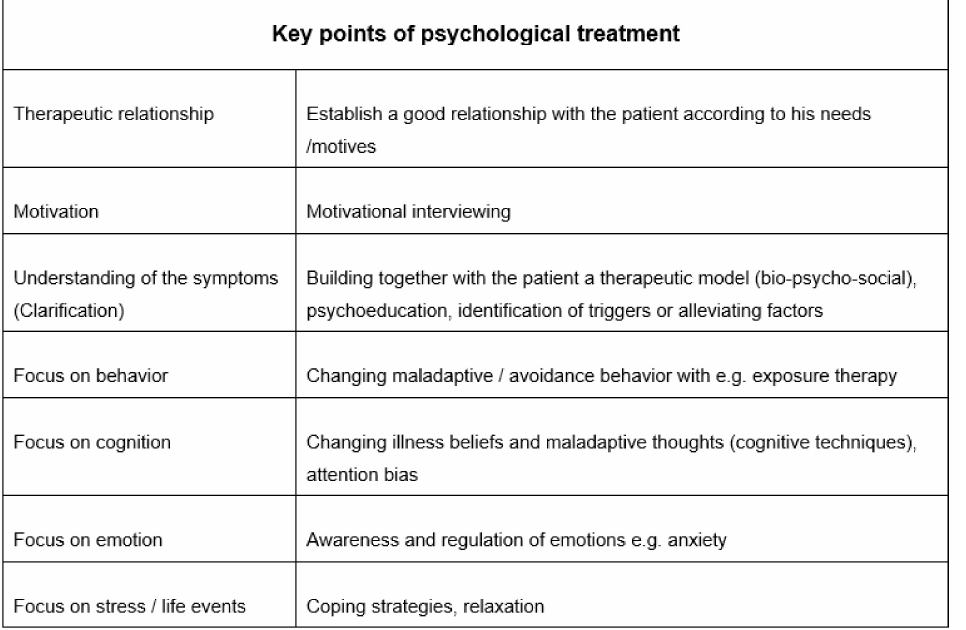
Figure 6. Key points of psychological